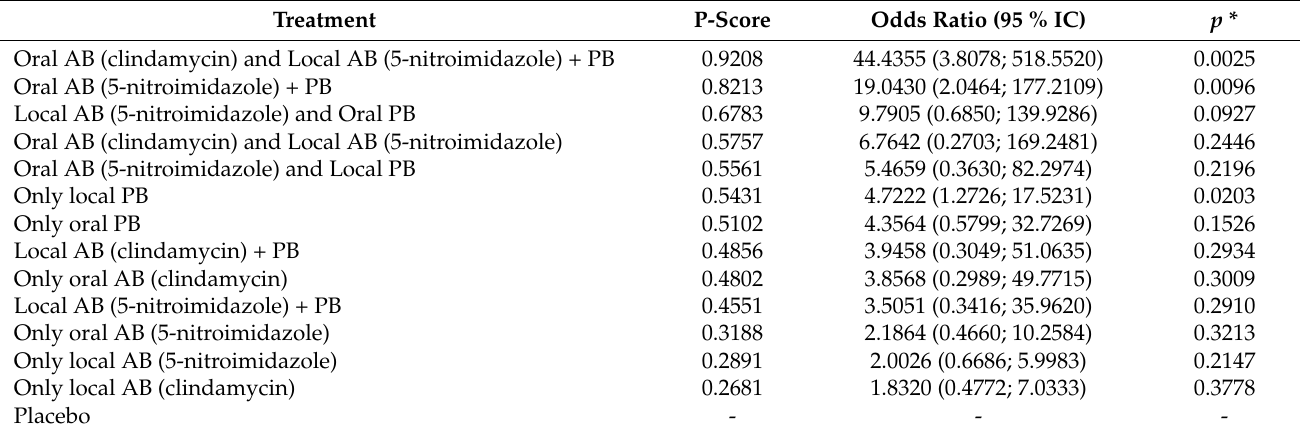
Table 3. P-scores ranked from different types of treatments for bacterial